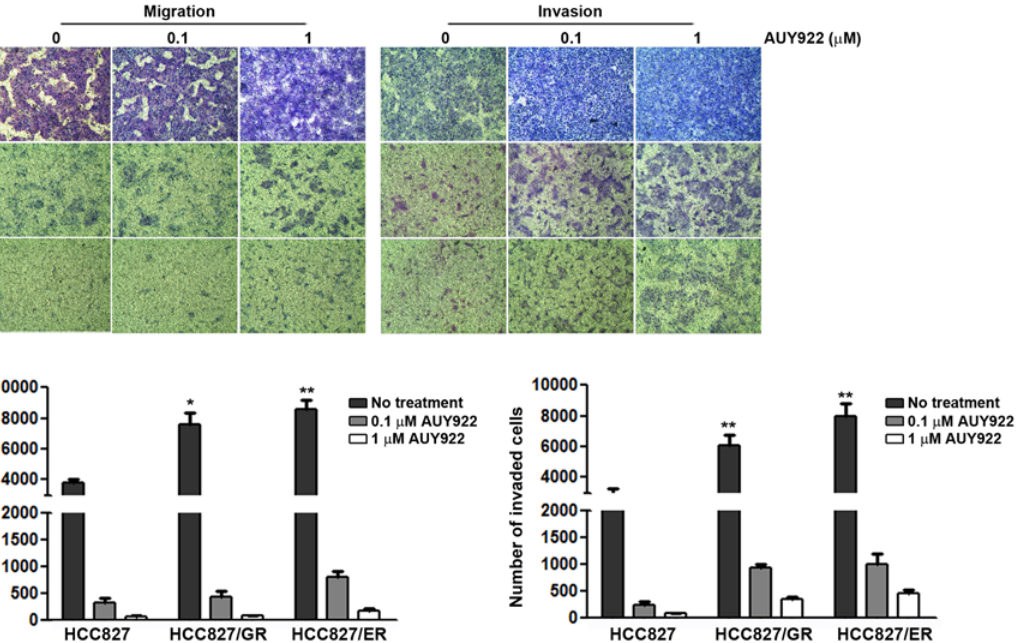
Fig 5. Reduced migratory and invasive capabilities of cancer cells following AUY922 treatment. Cells were seeded onto either collagen or matrigel- coated polycarbonate filters to determine their migratory and invasive potentials, respectively. Cells were incubated in modified Boyden chambers with or without the indicated doses of AUY922 for 24 hours, and the cells that penetrated the filter were stained and counted using a light microscope. Bars represent the mean ± SD of three wells. * p < 0.01 and ** p < 0.001 in comparison with HCC827 cells.